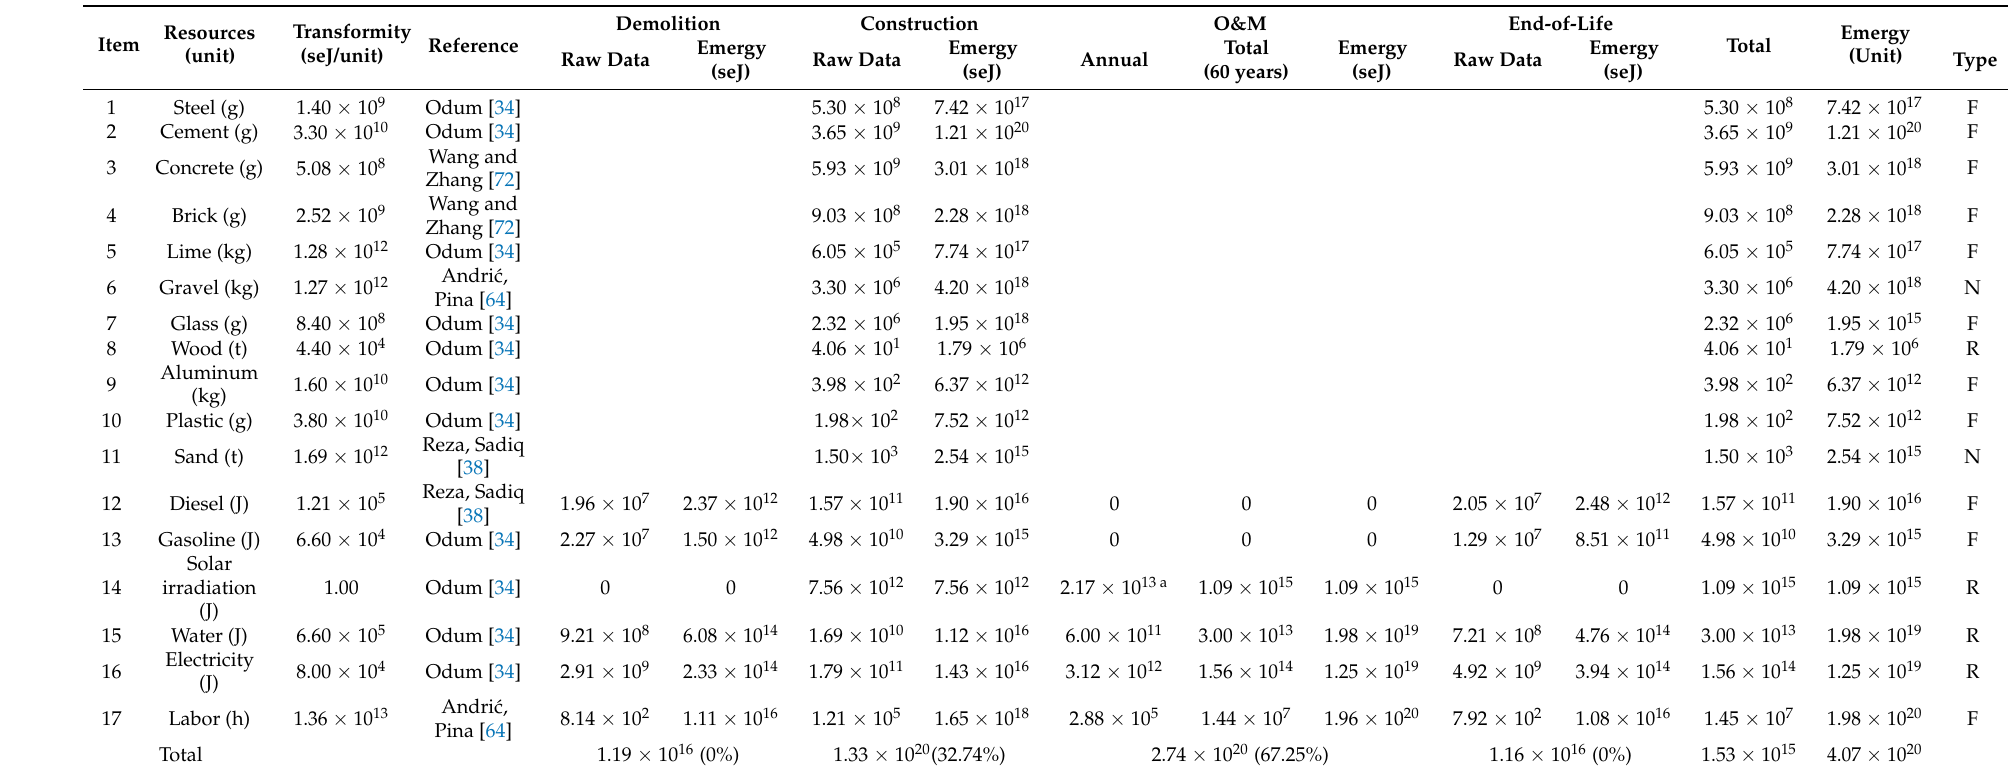
Table 4. Emergy table for the rebuilding